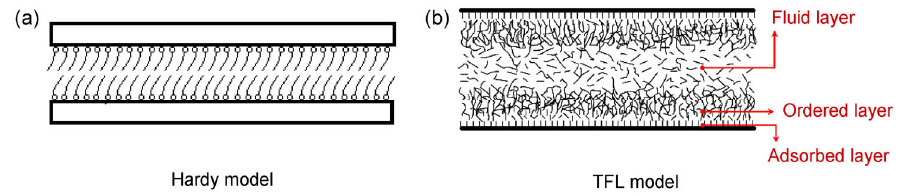
Fig. 1 Basic model of TFL [4, 5]. Copyright 1996,